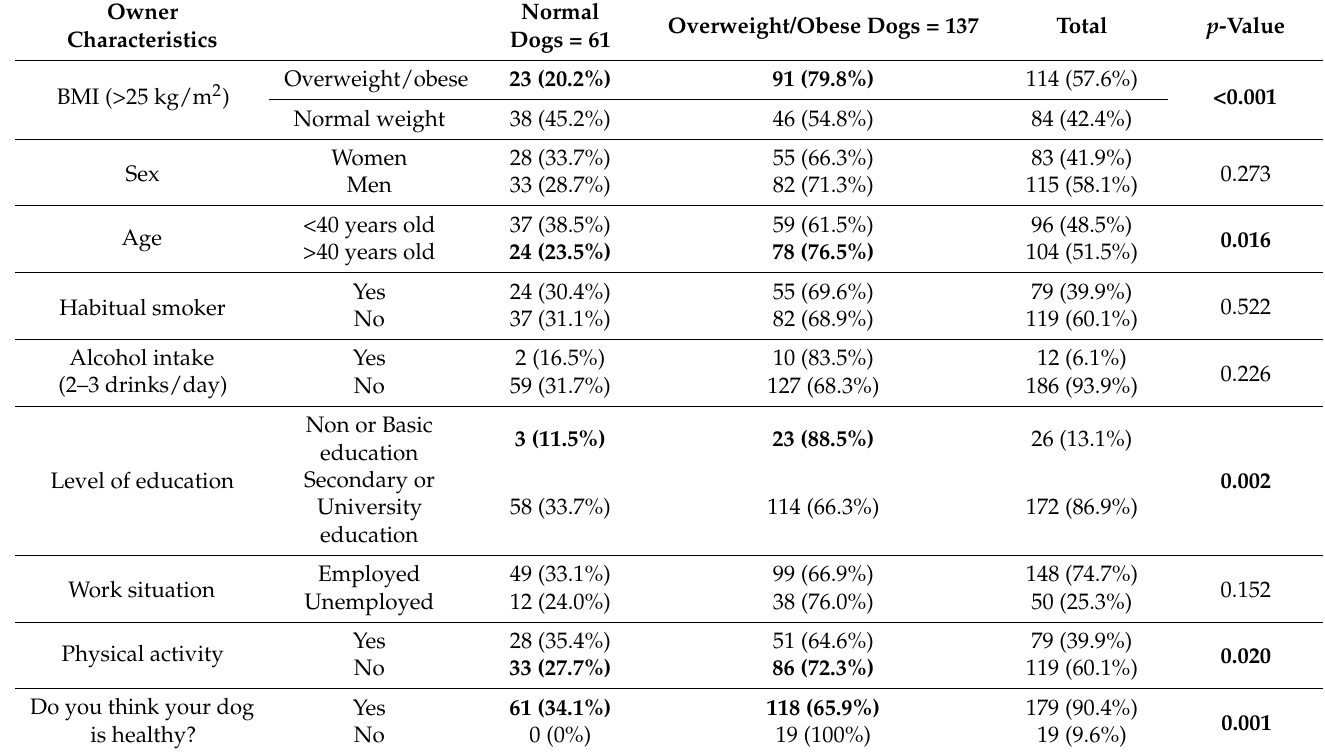
Table 2. Results of the studied variables related to the characteristics of the owners. The distribution of categorical variables was estimated using the χ 2 test and, when required, Fisher’s exact test was used. Statistical differences are highlighted